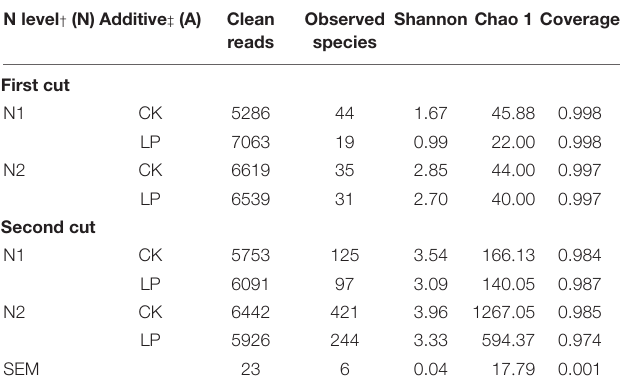
TABLE 3 | Bacterial alpha-diversity indices of forage mulberry